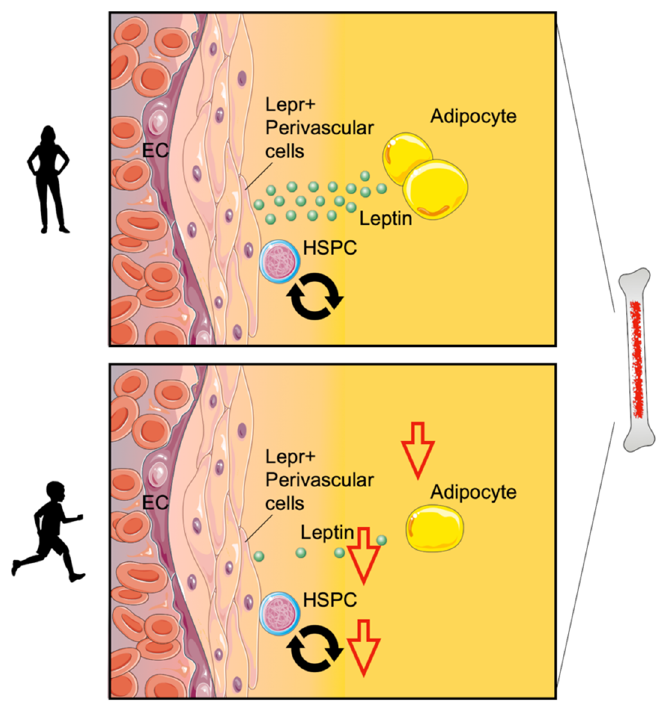
Figure 2. Exercise modulates bone marrow hematopoiesis. Physical exercise decreases hematopoi- etic stem and progenitor cell (HSPC) proliferation by inducing quiescence-promoting niche factors. Specifically, exercise decreases the production of adipose tissue-derived leptin and induces the ex- pression of quiescence and retention factors in leptin receptor-positive stromal bone marrow cells (Lepr+ perivascular cells).